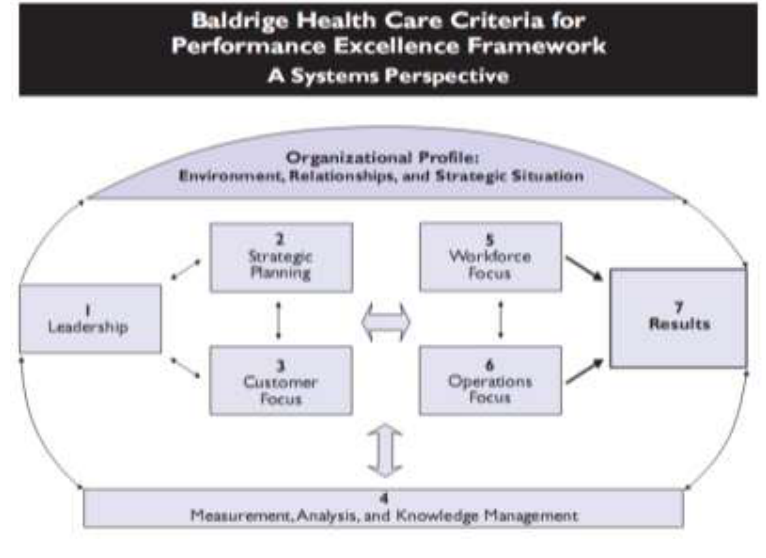
Figure 1. The Baldrige